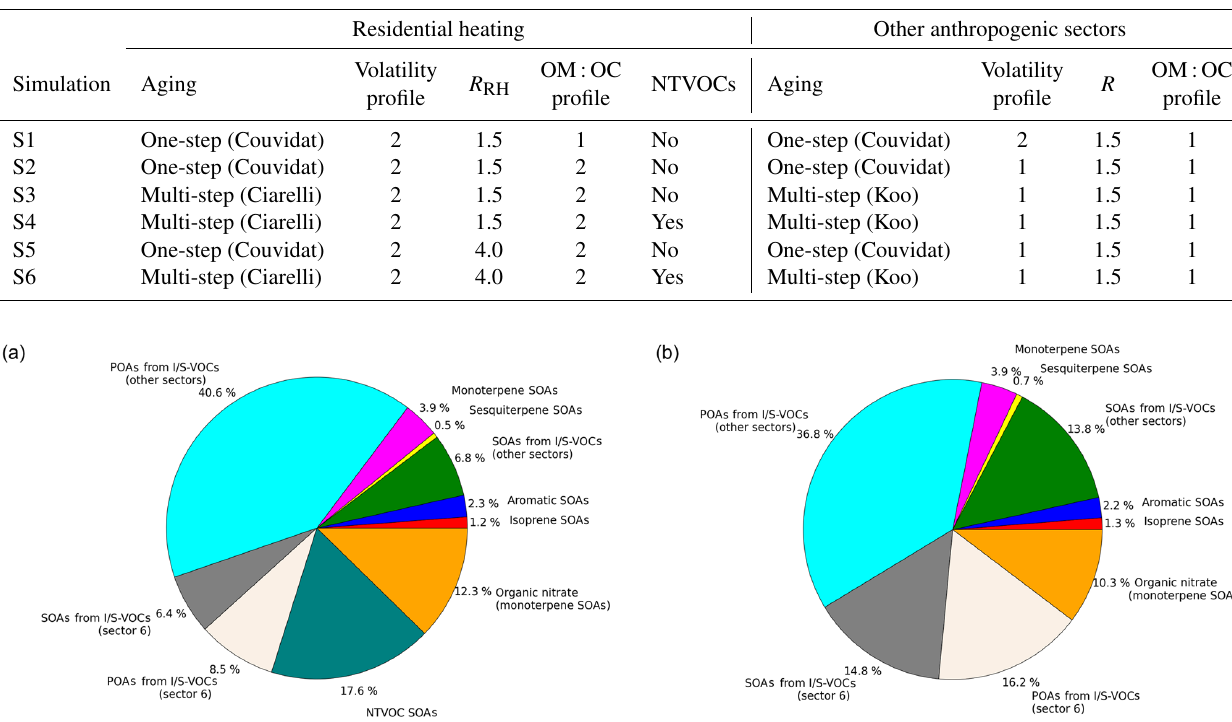
Table 4. Summary of the parameters used in the different simulations performed.